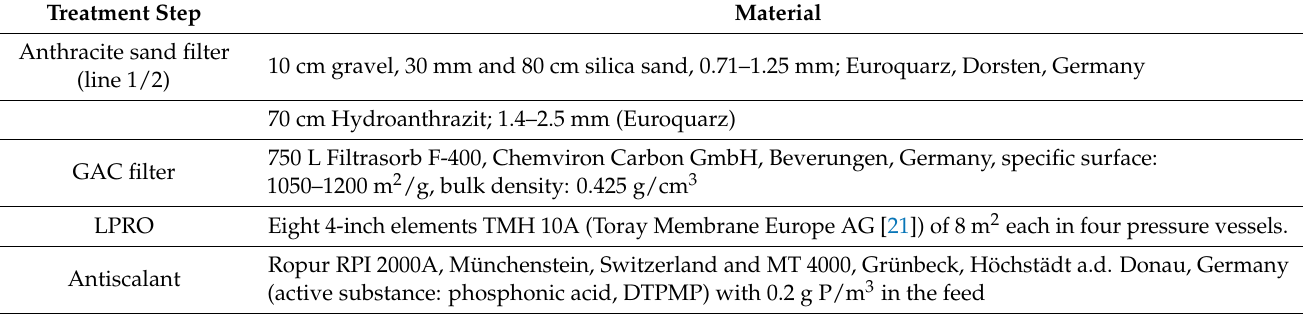
Table 3. Specifications of the materials used in the pilot plant. Treatment Step Material Anthracite sand